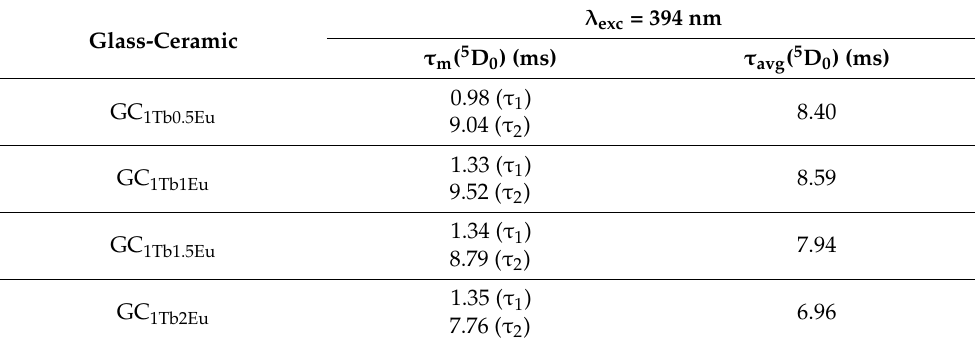
Table 4. Measured lifetimes and calculated average decay times of the 5 D 0 state (Eu 3+ ) in fabricated glass-ceramics ( λ exc = 394 nm